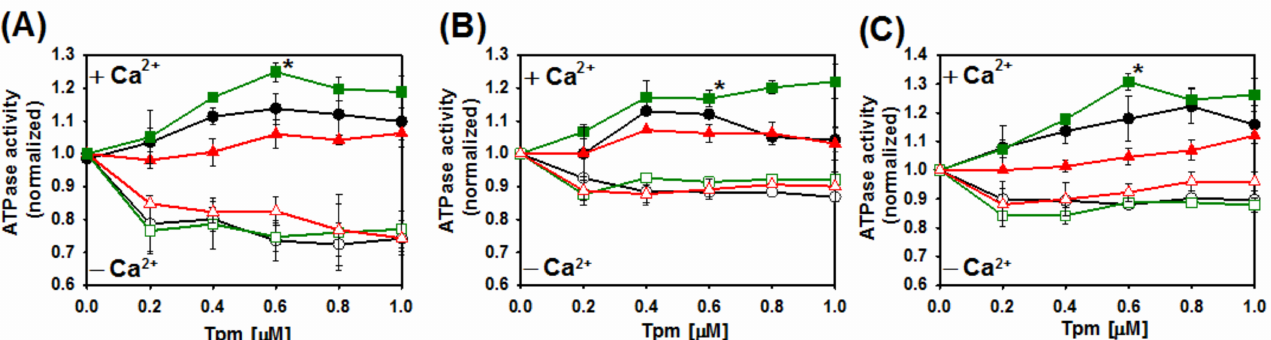
Figure 6. Calcium-dependent regulation of actin-activated myosin S1 ATPase of Tpm2.2 homodimers ( A ), crosslinked Tpm2.2/Tpm2.2 heterodimers ( B ), and crosslinked Tpm1.1/2.2 heterodimers ( C ). The ATPase regulated by Tpm2.2 (black circles), Tpm2.2-Q93H (red triangles), and Tpm2.2-E97K (green squares) in the presence of Tn + Ca 2+ (closed symbols) and Tn − Ca 2+ (open symbols) in 30 mM NaCl, 2 mM MgCl 2 , 5 mM imidazole, pH 7.0, 1 mM DTT and either 0.1 mM CaCl 2 or 0.2 mM EGTA. Protein concentrations: 5 µ M F-actin, 1 µ M myosin S1, Tn at 1.2 molar excess over Tpm. Data were analyzed using a one-way ANOVA at 0.6 µ M tropomyosin (* p ≤